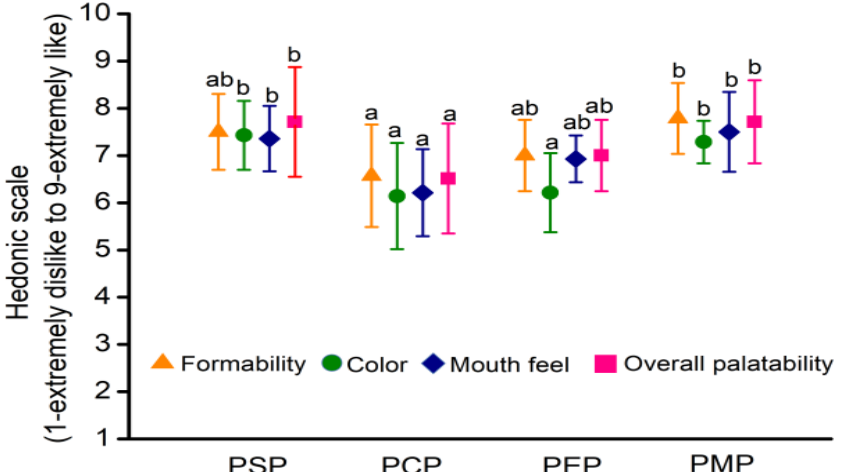
Figure 3. Sensory attributes of four P. eryngii papery food items. Each error bar indicates mean ± SD. Bars sharing the same letters are not different at p = 0.05. Letters should be compared for each variable across treatments. Different letters indicate that the mean values of three replicates are significantly different between the treatments ( p < 0.05).